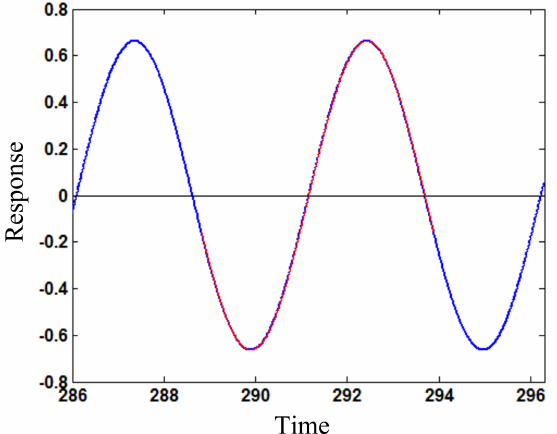
Figure 7. Stationary smaller-amplitude response ( w ) varying with time ( t ) for loading frequency ω = 1.24 (blue solid line: numerical simulation; red dotted line: the developed